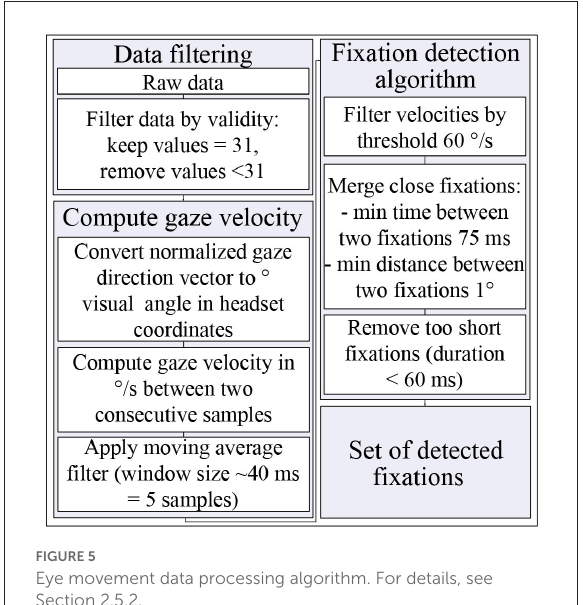
FIGURE5 Eye movement data processing algorithm. For details, see Section